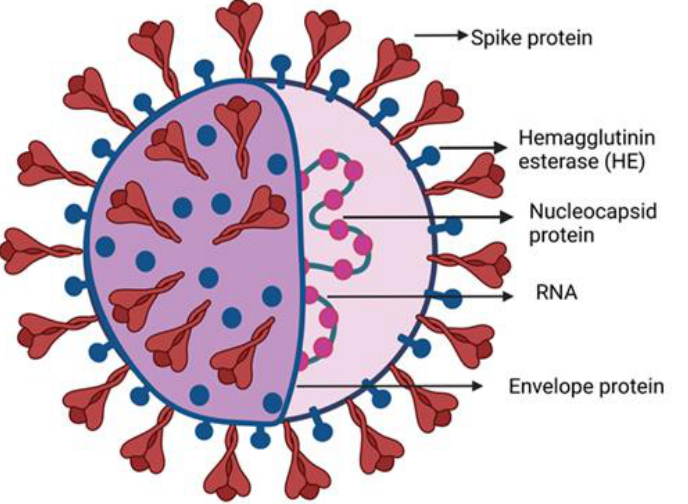
Figure 1. SARS-CoV-2 structure diagram. The majority of building proteins include spike (S), membrane (M), envelope (E), and nucleocapsid (N). The viral envelope and a lipid bilayer derived from the host cell membrane contain the proteins S, M, and E. The N protein binds to the viral RNA at the virion’s